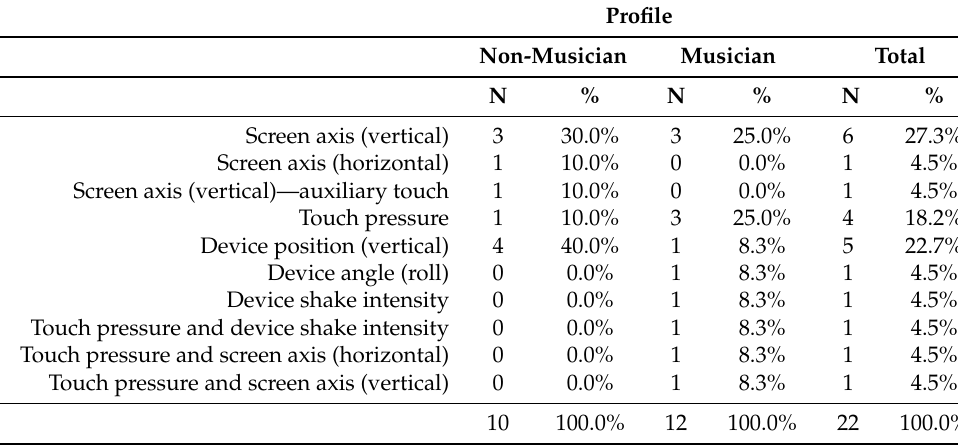
Table A12. Amplitude variation mapping (uncategorized)—stimulus c.